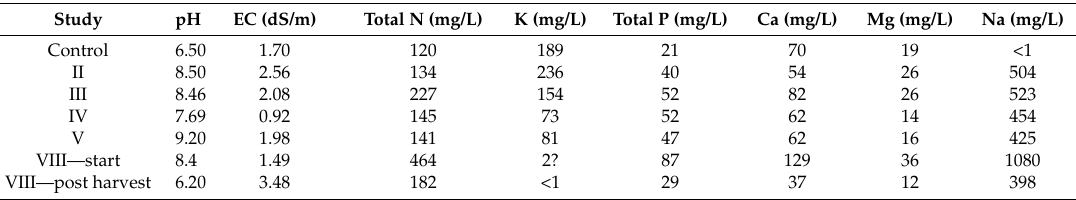
Table 1. Chemical composition and other properties of control and vermiliquer solutions before buffering at the start of Studies II-V and start and end of Study